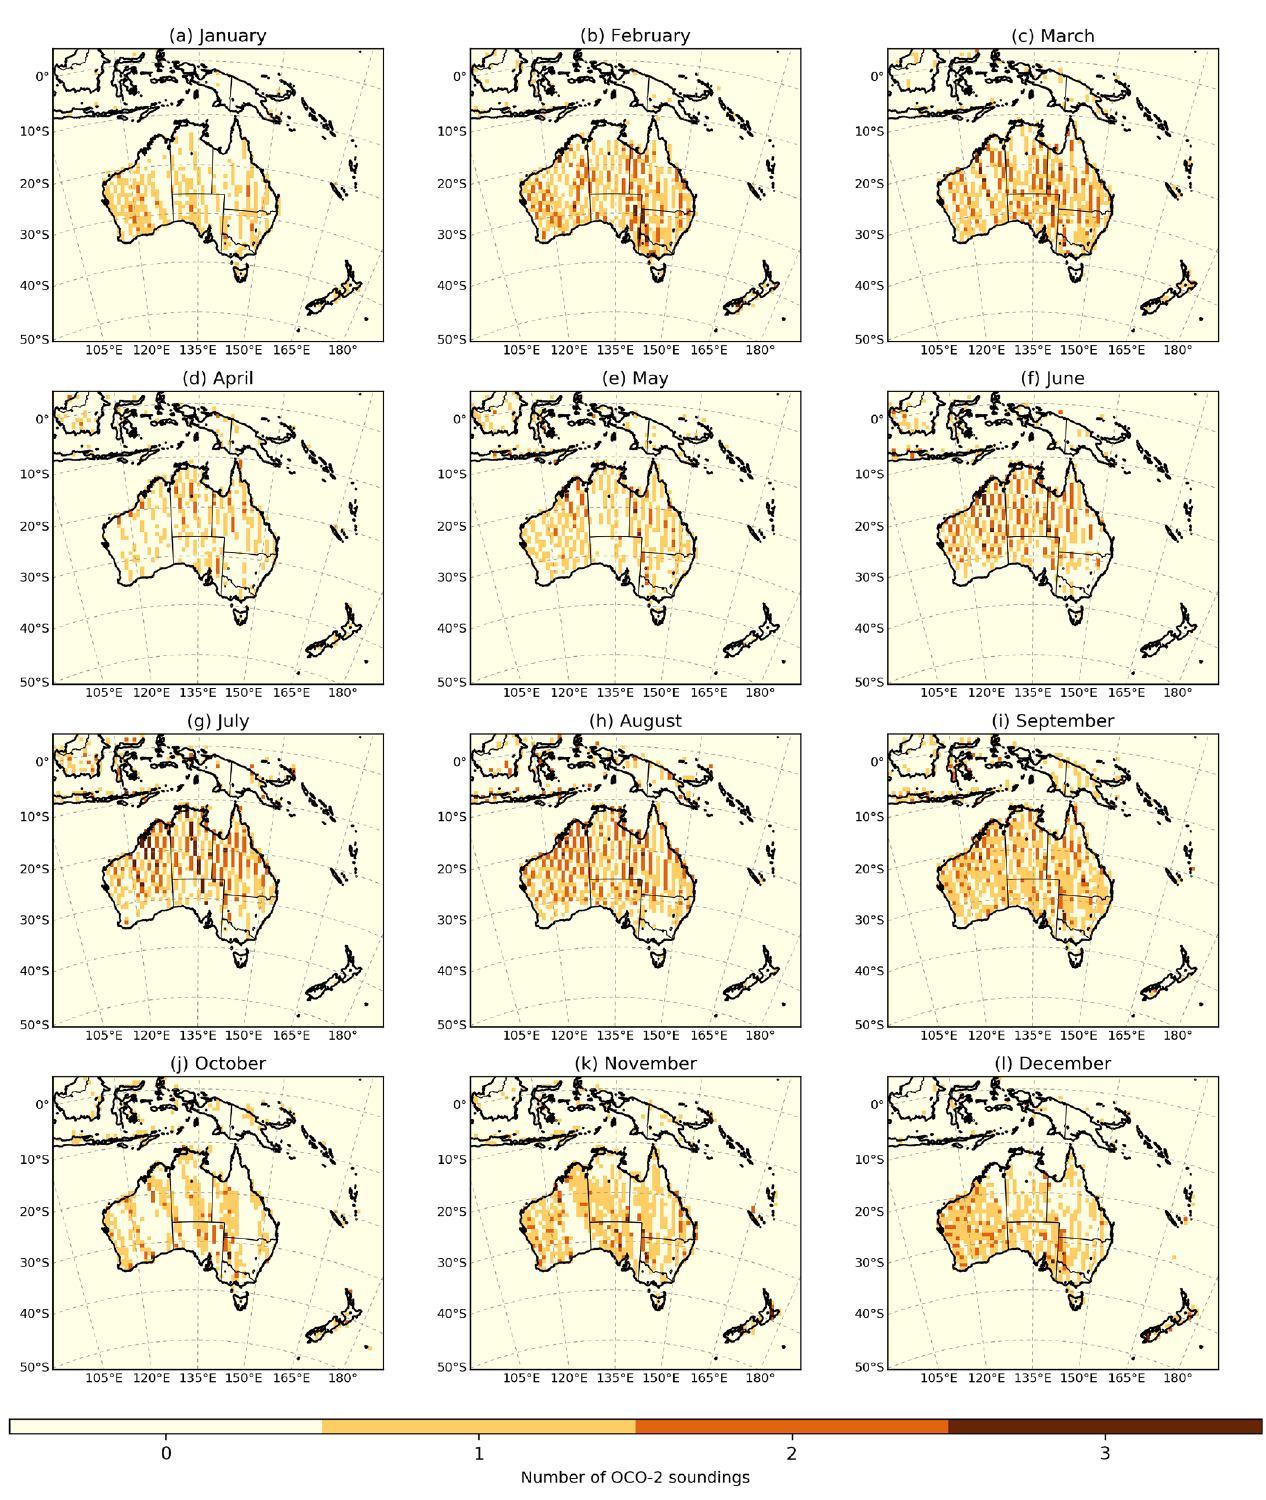
Figure C1. Spatial distribution of OCO-2 soundings (LNLG) over the CMAQ domain for 2015. Atmos. Chem. Phys., 21, 17453–17494, 2021